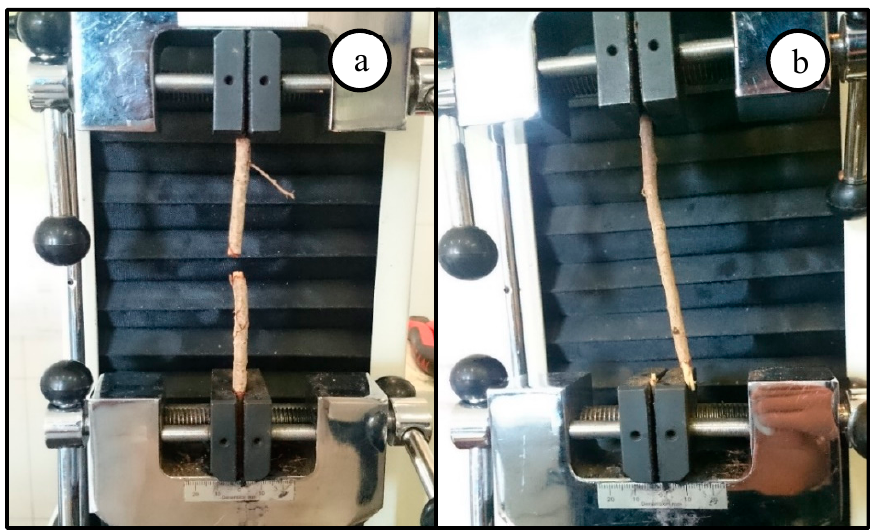
Figure 2. Breaking phase of the root in tensile test. A valid test, where the root broke near the middle (a), and an invalid test, where the root broke proximate the clamp (b).